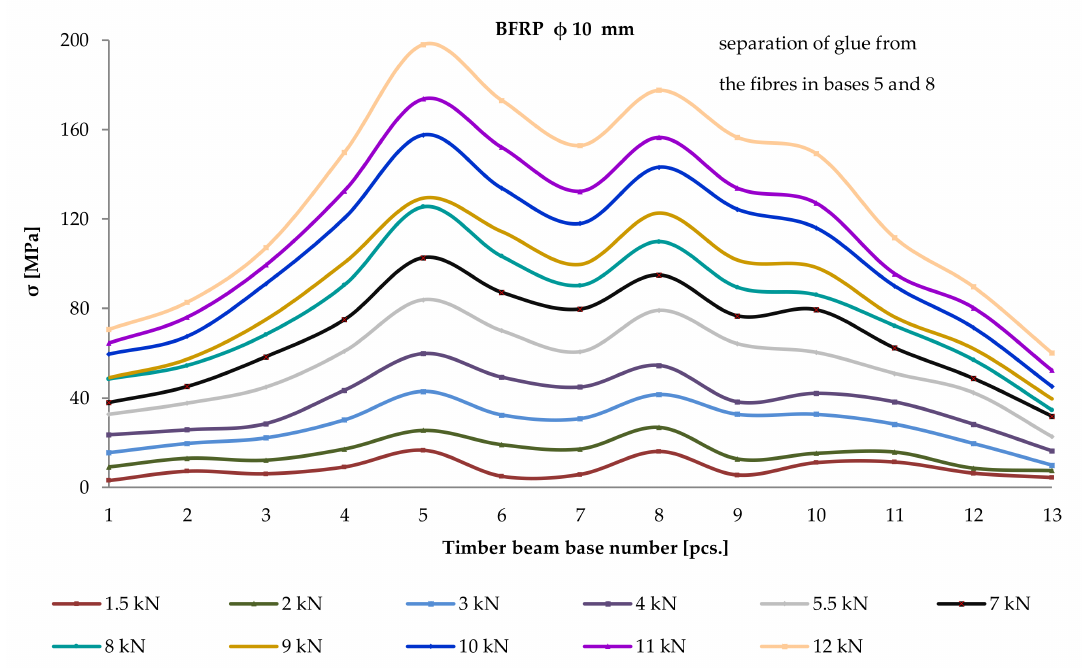
Figure 8. Distribution of normal stresses in the BFRP fibres σ (MPa) over the entire length of a reinforced beam W BFRP